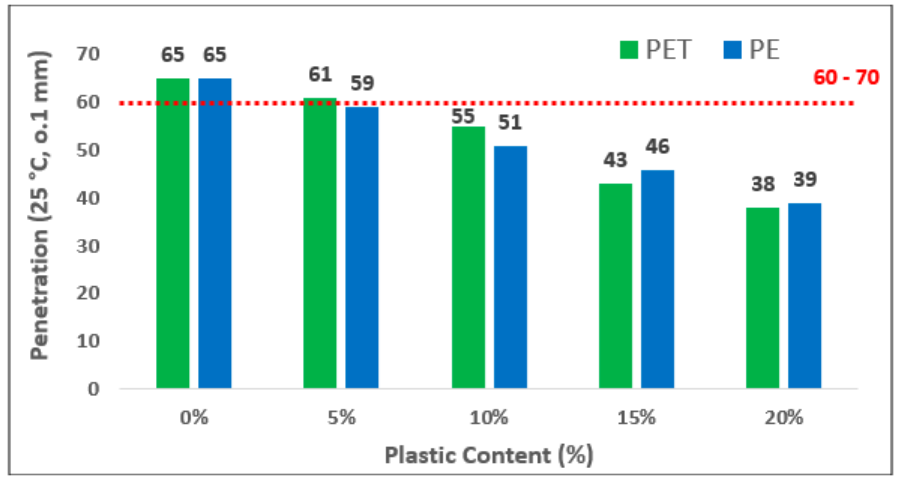
Figure 6. Penetration of Modified Bitumen versus different Plastic contents .